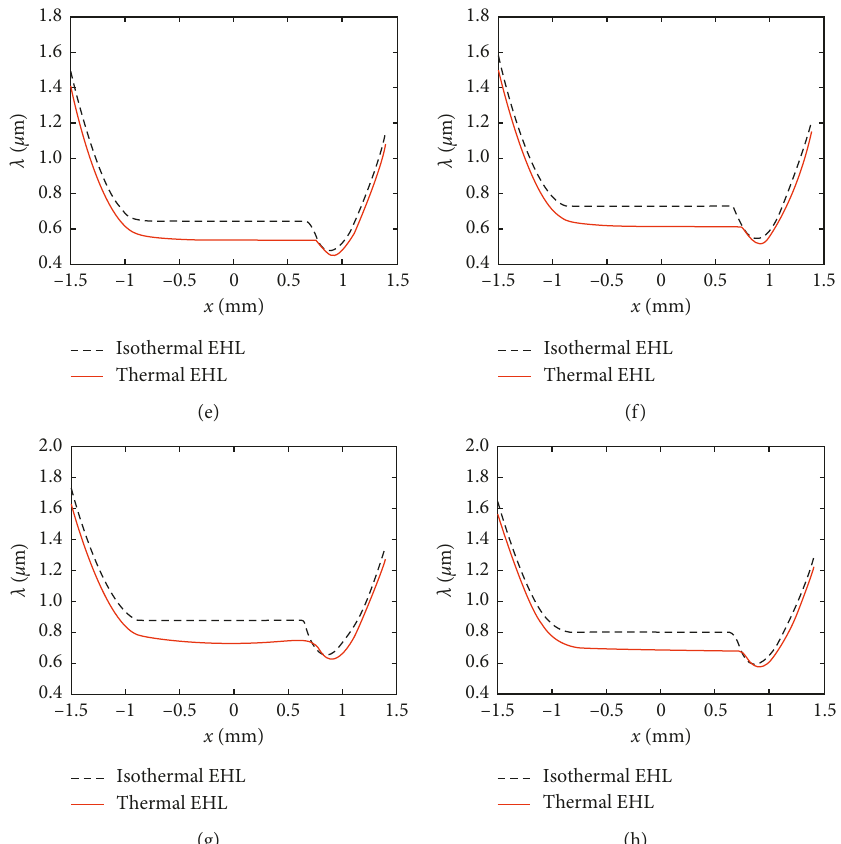
Figure 15: Comparison of film pressure distribution results under isothermal and thermal EHL lubrication at the velocity of (a) 2.5m/s, (b) 3.0m/s, (c) 3.5m/s, and (d) 4.0 m/s and film thickness distribution-comparison of results under the isothermal and thermal EHL lubrication at the velocity of (e) 2.5 m/s, (f) 3.0m/s, (g) 3.5m/s, and (h)